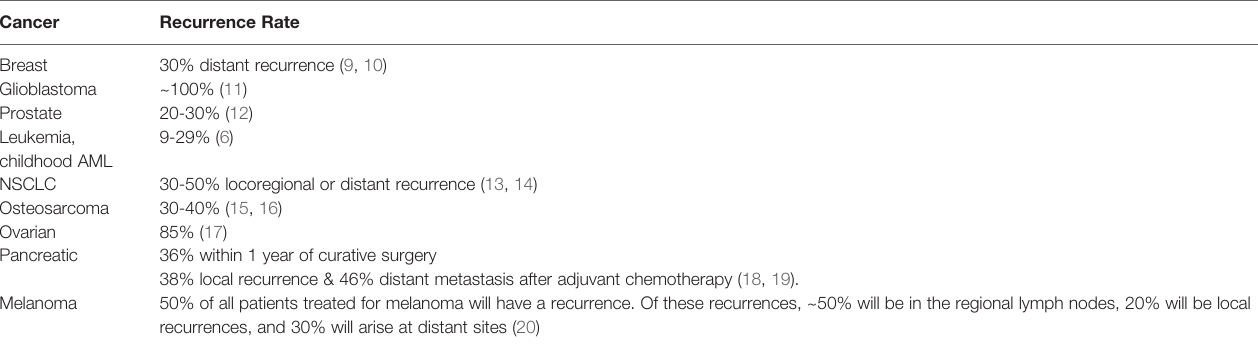
TABLE 1 | Estimated Recurrence Rate of Various